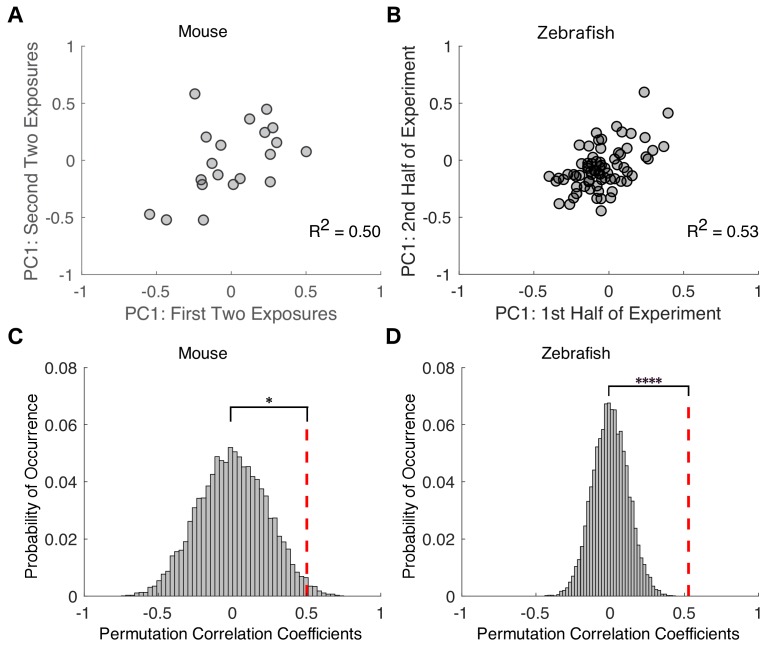
Variability in drug sensitivity is a stable characteristic of an individual at steady state equilibrium.Transition probability matrices were independently estimated for each mouse across the first two and last two of exposures to isoflurane and projected onto the first principal component. For zebrafish, transition probability matrices were estimated for the first and second halves of propofol exposure. Negative values represent animals that had a high probability of staying responsive and low probability of staying unresponsive, whereas positive values represent animals that had a high probability of staying unresponsive and low probability of staying responsive. (A) In mice, individual transition probability matrices estimated separately for the first two and the last two exposures to 0.6% isoflurane were correlated (R2 = 0.50, p=0.025, Pearson’s R ). (B) In zebrafish, individual transition probability matrices estimated separately for the first and second halves of the exposure to 3 μM propofol were correlated (R2 = 0.53, p<0.0001, Pearson’s R ). (C) Permutation test reveals that, in mice, experimentally observed within-subject correlations are significantly higher than in inter-subject shuffled surrogates (p=0.013). (D) Permutation test computed for zebrafish (p<0.0001). Statistical significance is shown by *p<0.05 ****p<0.0001. Source data for correlation plots described are available in the Figure 5—source data 1.Figure 5—source data 1.PC1 values in mice for exposures 1/2 and 3/4 and in zebrafish for first and second half of exposure.